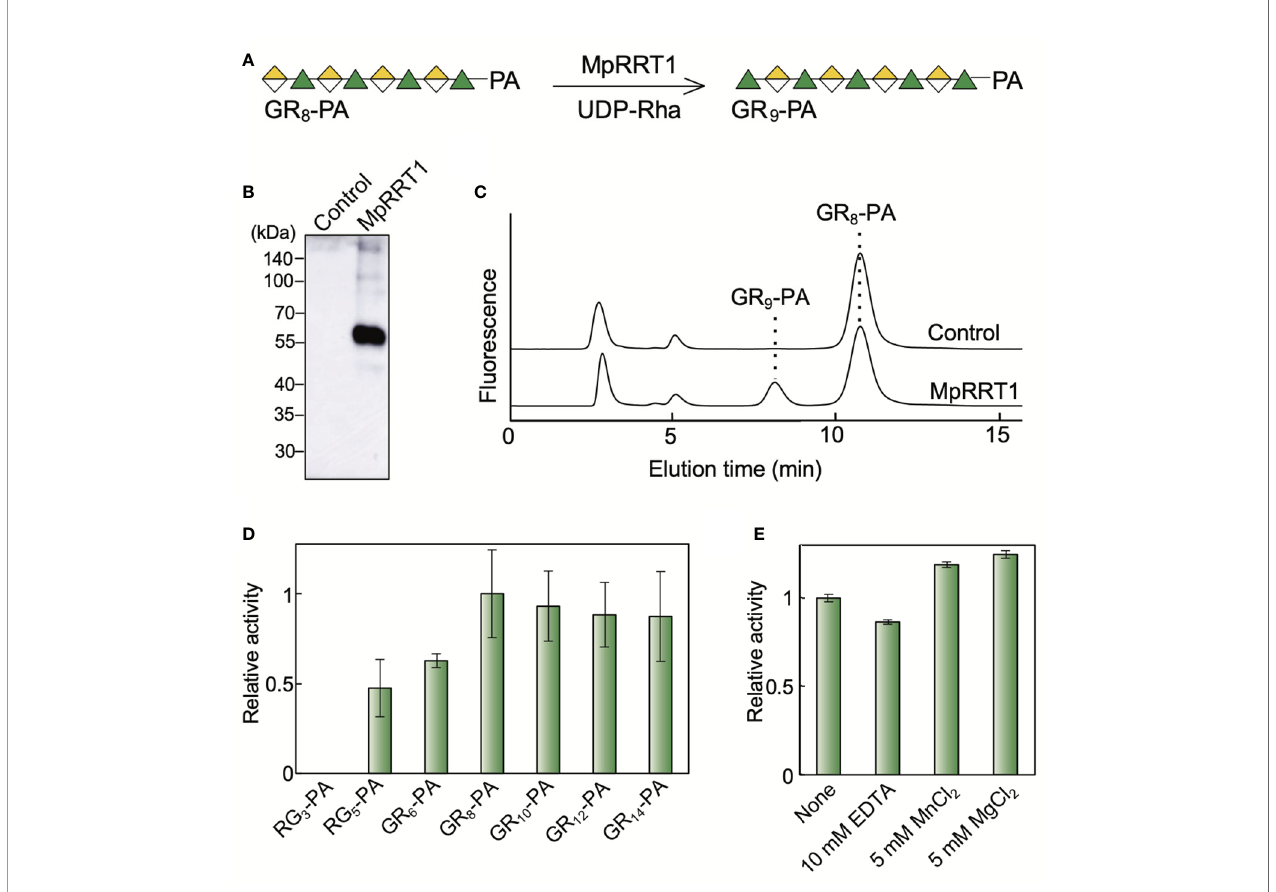
FIGURE 1 | MpRRT1 has RG-I rhamnosyltransferase activity. (A) Reaction scheme for MpRRT1. Green triangles and yellow-divided diamonds represent Rha and GalUA residues, respectively. The fl uorescent pyridylamino group (PA) is covalently linked to the reducing-end of the oligosaccharides. (B) SDS-PAGE of the recombinant MpRRT1 protein with a C-terminal FLAG tag expressed in tobacco leaves. The protein was detected by immunoblotting using an anti-FLAG antibody. The control proteins were prepared from tobacco leaves in fi ltrated with the empty pBI121 vector with the same procedure as that used to prepare MpRRT1. (C) Rhamnosyltransferase activity of MpRRT1. The recombinant protein was reacted with 50 µM GR 8 -PA and 0.5 mM UDP-Rha at 30°C for 1 h. The upper and lower chromatograms represent after the enzyme reaction with the fraction from control proteins and MpRRT1, respectively. The enzyme product GR 9 -PA was detected after the enzyme reaction with MpRRT1. (D) Acceptor substrate speci fi city of MpRRT1. The structures of acceptor oligosaccharides are shown in Supplementary Table 2 . (E) Divalent cation-dependence of MpRRT1. Values are presented as the mean of three biologically independent samples with